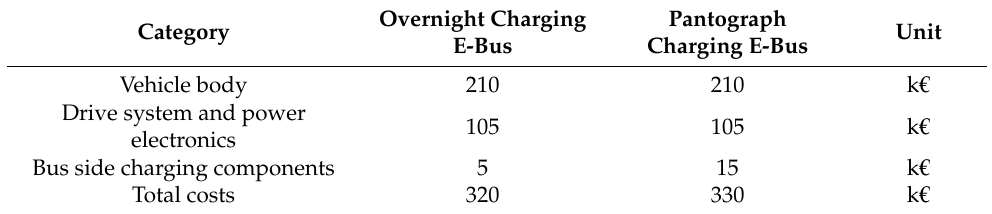
Table 1. Purchase costs of electric battery buses for two different charging methods. Category